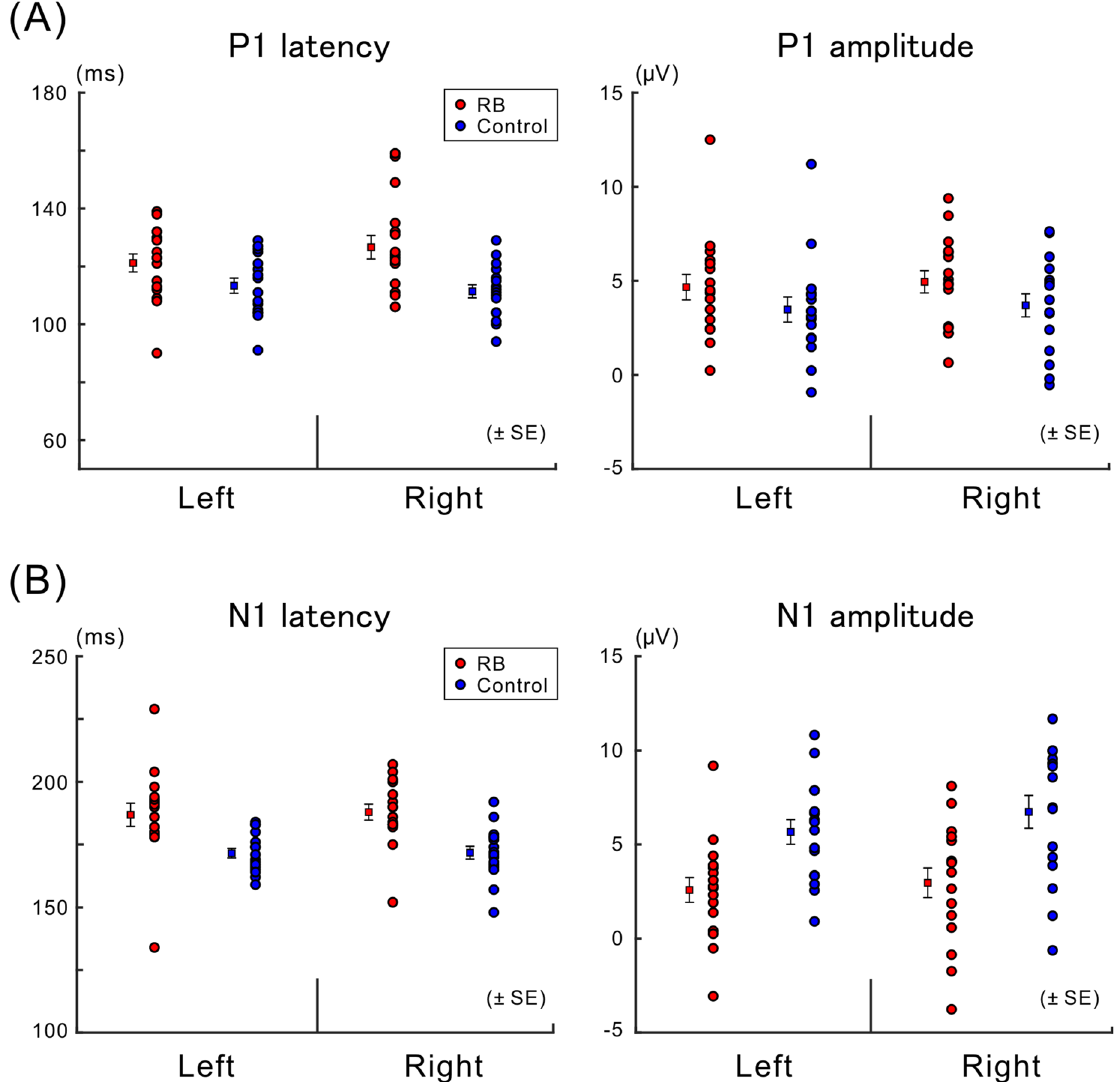
Figure 4. Latencies and amplitudes of VEPs. ( A ) Mean of peak latencies (left) and mean of peak amplitudes (absolute values) (right) for P1 with their respective means are illustrated across participants. The P1 latency in the RB condition was significantly longer than that in the Control condition ( p < 0.001), and the P1 amplitude in the RB condition was significantly larger than that in the Control condition ( p < 0.006). ( B ) Mean of peak latencies (left) and mean of peak amplitudes (absolute values) (right) for N1 with their respective means are illustrated across participants. The N1 latency in the RB condition was significantly shorter than that in the Control condition ( p < 0.001), whereas the N1 amplitude in the RB condition was significantly smaller than that in the Control condition ( p <